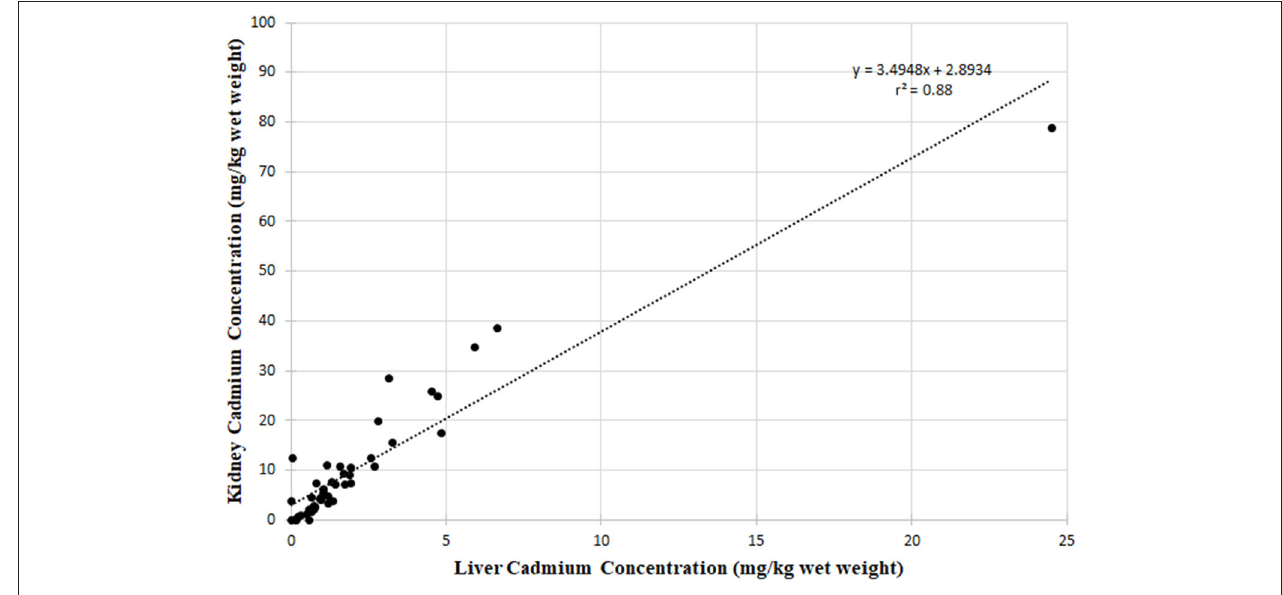
FIGURE 6 | Organ tissue cadmium concentrations from pooled dataset.